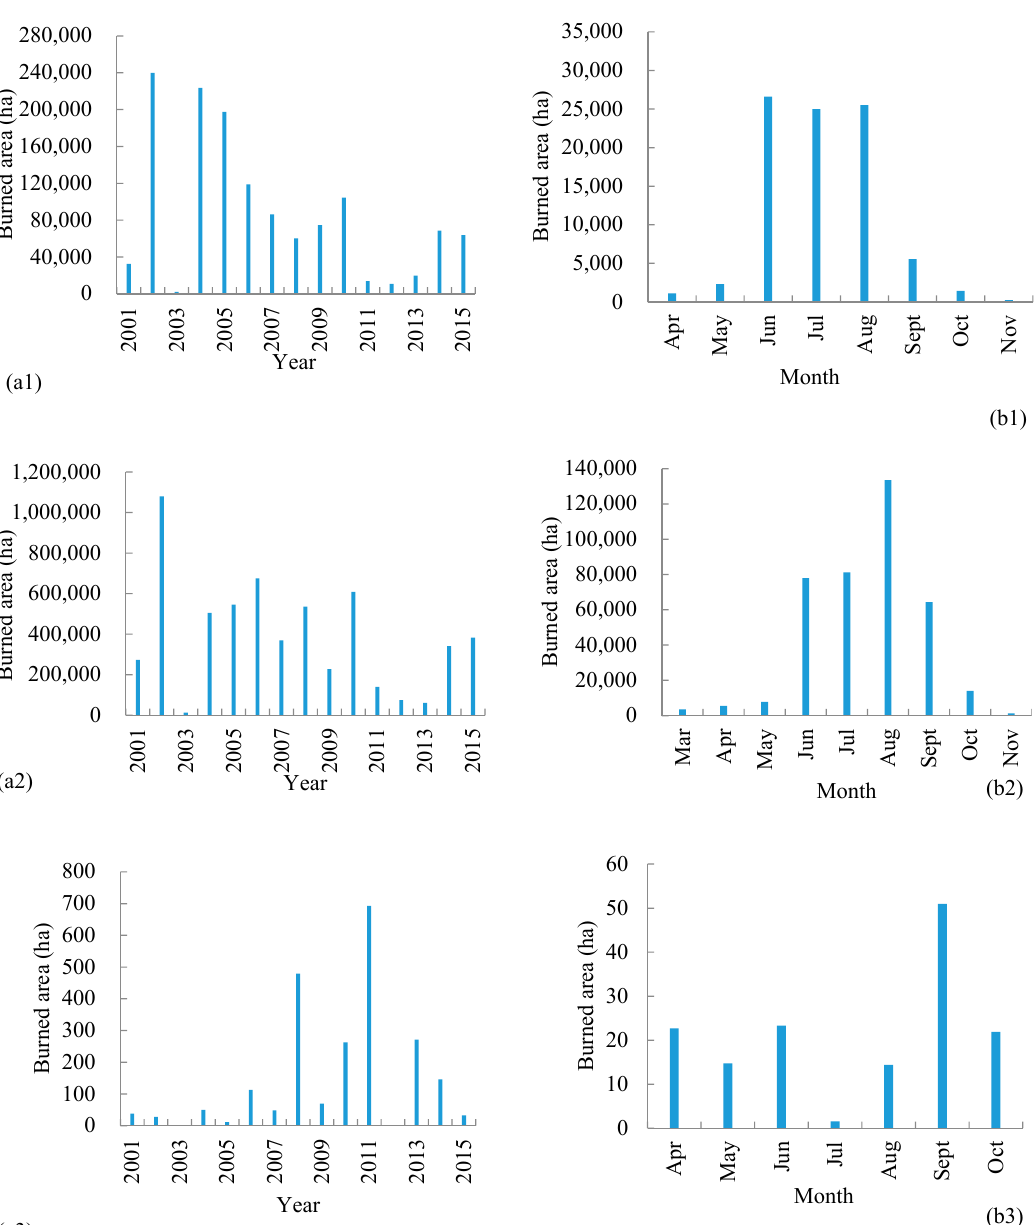
Figure 5. Annual and monthly burned areas for three vegetation zones during the 2001–2015 period. ( a1 ) the mean annual burned areas in R1; ( a2 ) the mean annual burned areas in R2; ( a3 ) the mean annual burned areas in R3; ( b1 ) the mean monthly burned areas in R1; ( b2 ) the mean monthly burned areas in R2; ( b3 ) the mean monthly burned areas in R3.